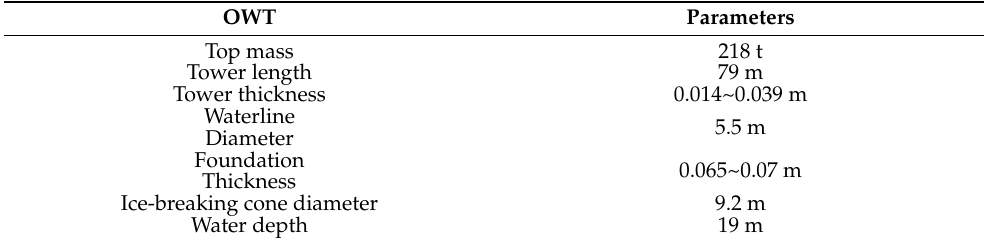
Table 1. Basic properties of the OWT